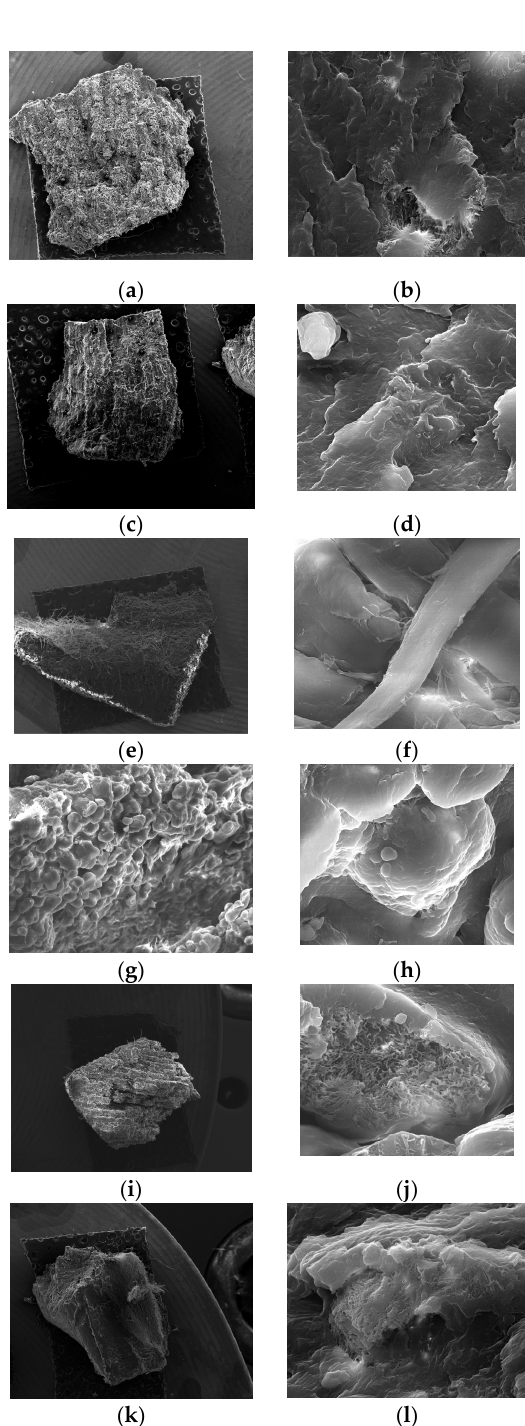
Figure 5. Micrographs of samples made of PA 2200 by SLS: ( a , b ) Sample No. 3 made using a P = 4.5 W laser power and y = 0 ◦ orientation; ( c , d ) Sample No. 15 made by SLS using a P = 4.5 W laser power and y = 90 ◦ orientation; ( e , f ) Sample No. 25 made by SLS using a P = 4 W laser power and y = 0 ◦ orientation; ( g , h ) Sample No. 31 made by SLS using a P = 4 W laser power and y = 90 ◦ orientation; ( i , j ) Sample No. 45 made by SLS using a P = 4.5 W laser power and z = − 45 ◦ orientation; ( k , l ) Sample No. 45 made by SLS using a P = 4.5 W laser power and z = +45 ◦ orientation. From the fourth batch of five samples made from PA 2200 by the selective laser sin- tering technology, using a P = 4 W laser power and oriented at y = 90 ◦ , Sample No. 31 presented the most prominent fracture surface resulting from the compression test, as shown in Figure 5g. As can be seen in Figure 5h, the sintered layer’s surface was